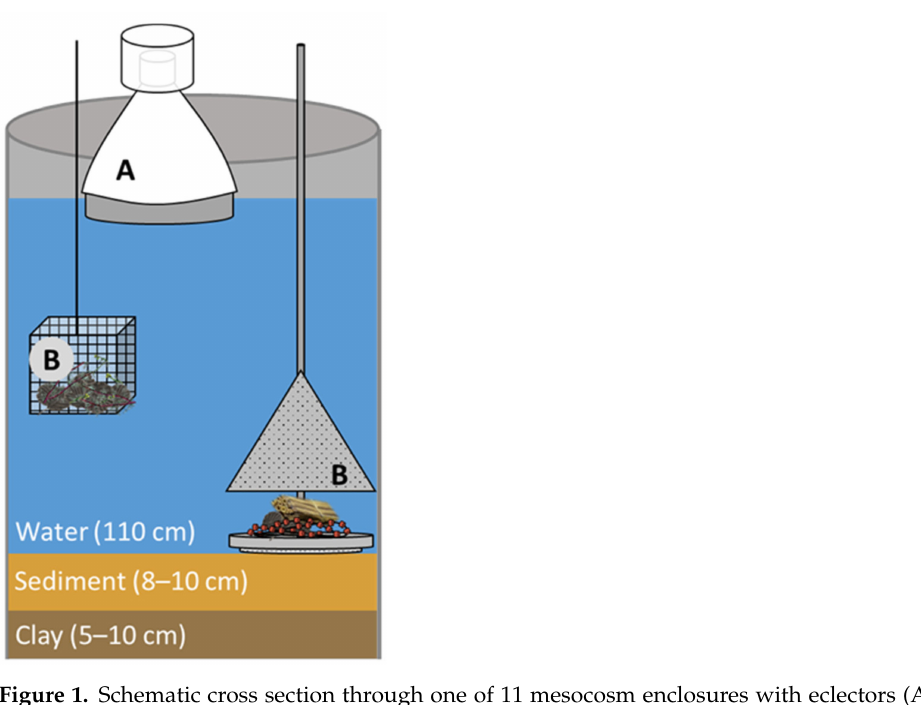
Figure 1. Schematic cross section through one of 11 mesocosm enclosures with eclectors (A) and macroinvertebrate traps (B) filled with macrophytes, leaves and habitat-forming